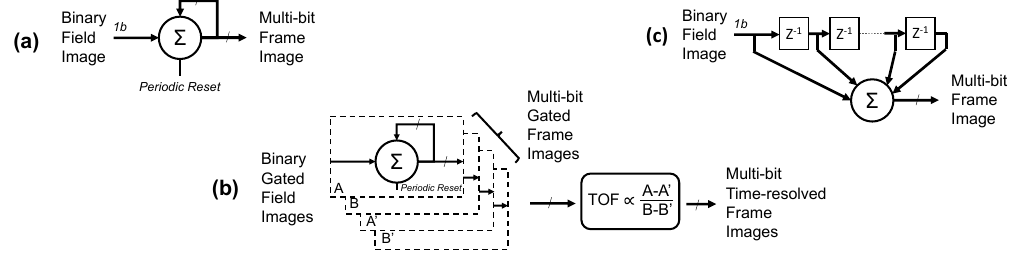
Figure 7. Per-pixel spatio-temporal oversampling techniques. ( a ) Intensity image using IIR with periodic reset [17]; ( b ) Time-resolved image: four IIR per pixel [18]; ( c ) High frame rate intensity image using first-order FIR per pixel [19].